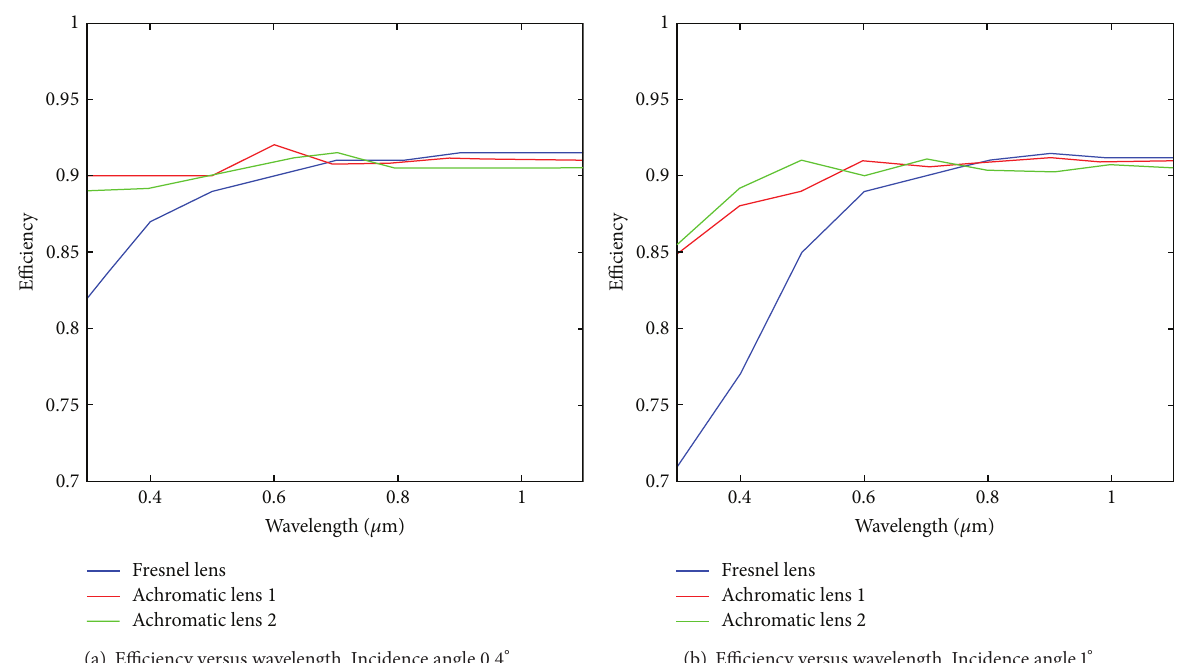
Figure 7: Efficiency of achromatic and standard Fresnel lenses for 0.4 ∘ and 1 ∘